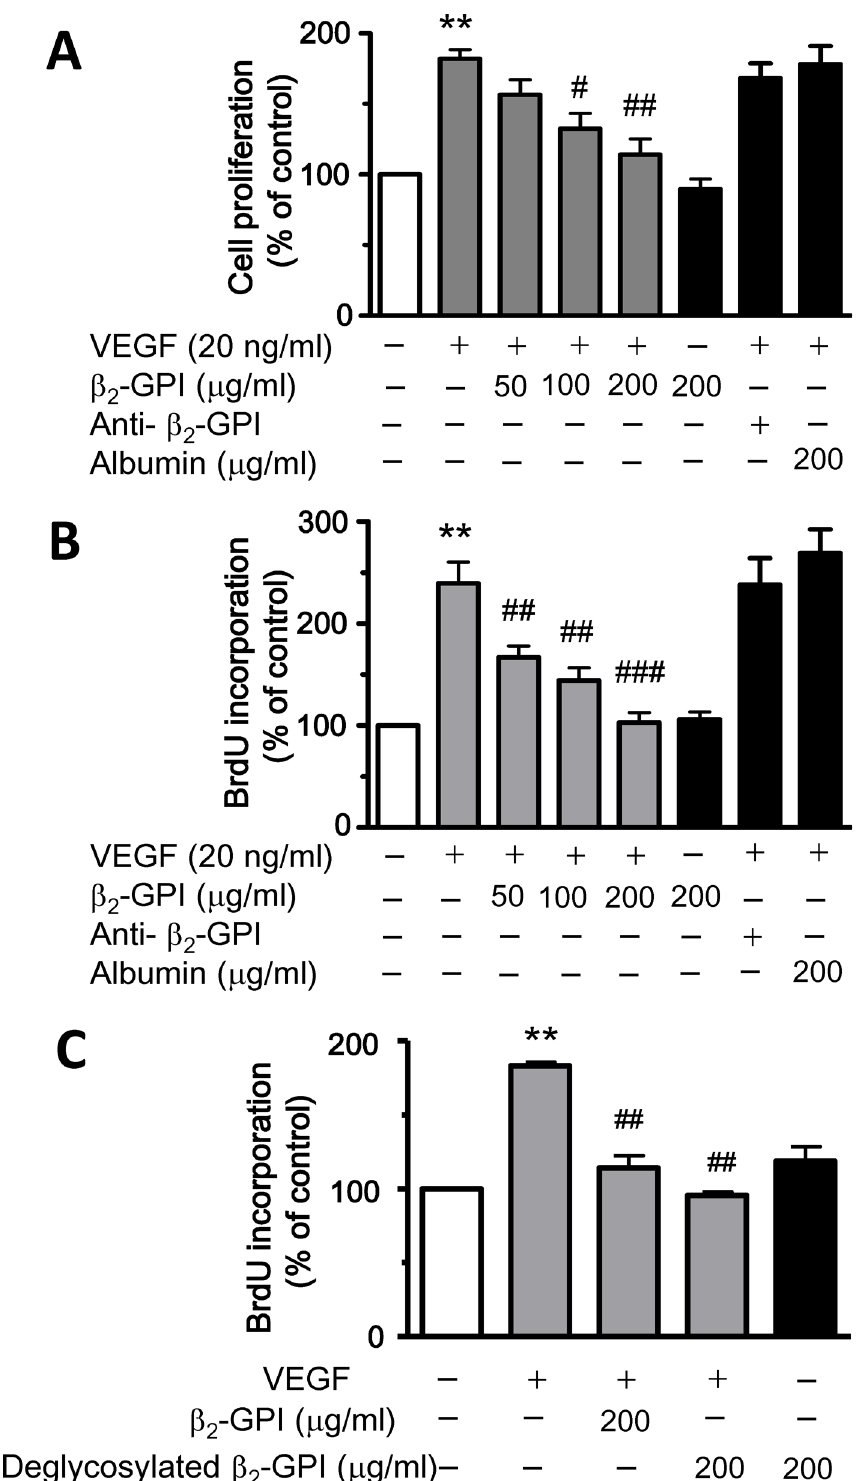
Fig 1. β 2 -GPI and deglycosylated β 2 -GPI inhibits the VEGF-induced proliferation in HAECs. (A) HAECs were treated with or without VEGF in combination with β 2 -GPI at indicated concentrations for 72 h and were incubated with 3-(4,5-dimethylthiazol-2-yl)-2,5-diphenyltetrazolium bromide (MTT) for another 4 h. Then the effect of β 2 -GPI on VEGF-induced cell proliferation was determined by MTT assay. Treatment of anti- β 2 -GPI